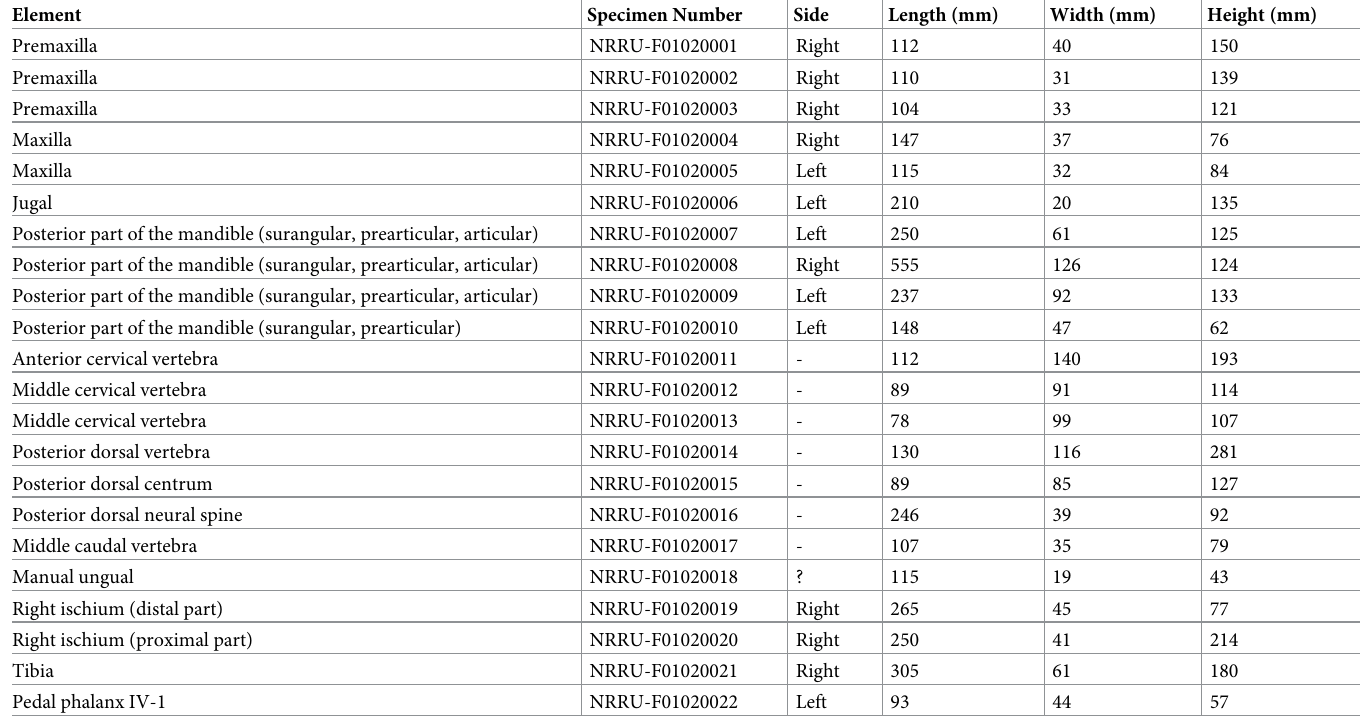
Table 1. Measurements of the described materials of Siamraptor suwati